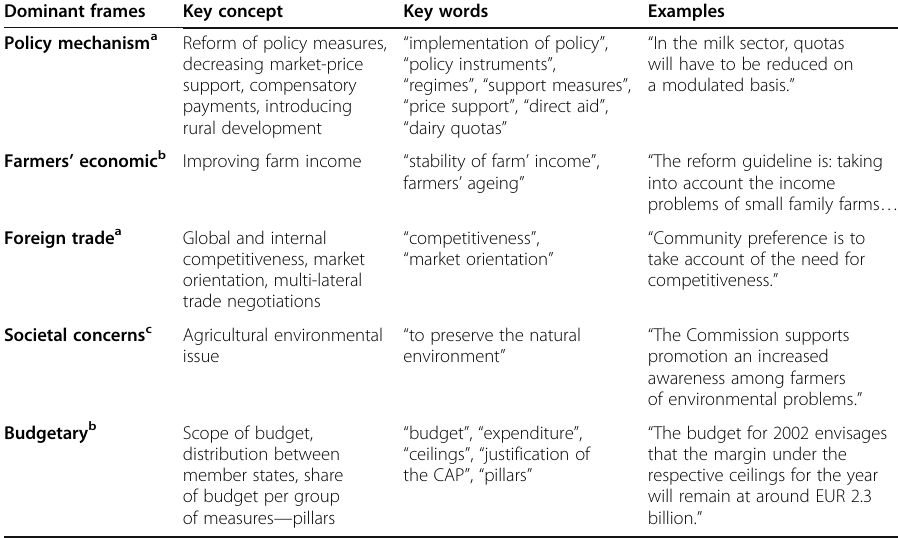
Table 2 Frame matrix of five frames used in European Commission Communications on CAP reforms (1991 and 1997) — production-coupled support (1992 –